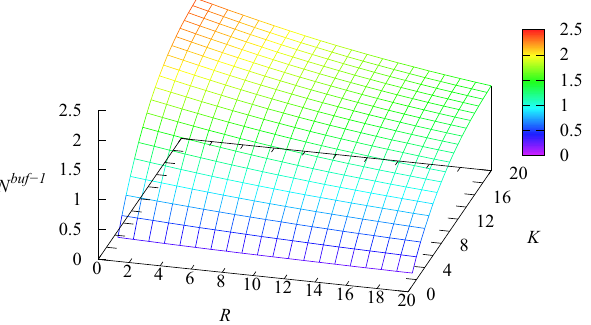
Figure 11. Dependence of the mean number of requests N buf − 1 in the first buffer on K and R .